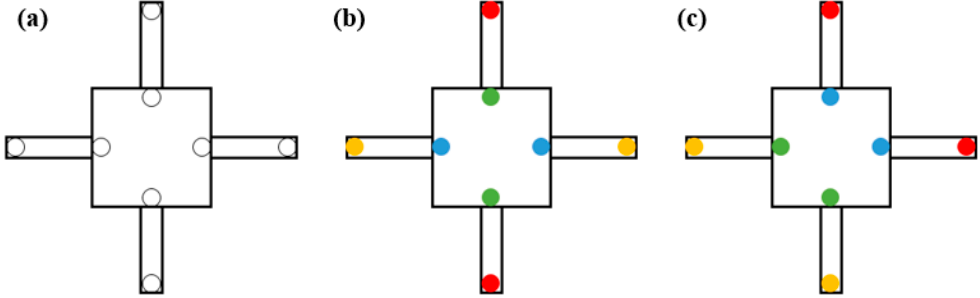
Figure 3. Top view of the quadrupedal robot. ( a ) Joint asymmetry in the quadrupedal robot. ( b ) Diagonal joint symmetry is shown in the quadrupedal robot. ( c ) Adjacent joint symmetry is shown in the quadrupedal robot.